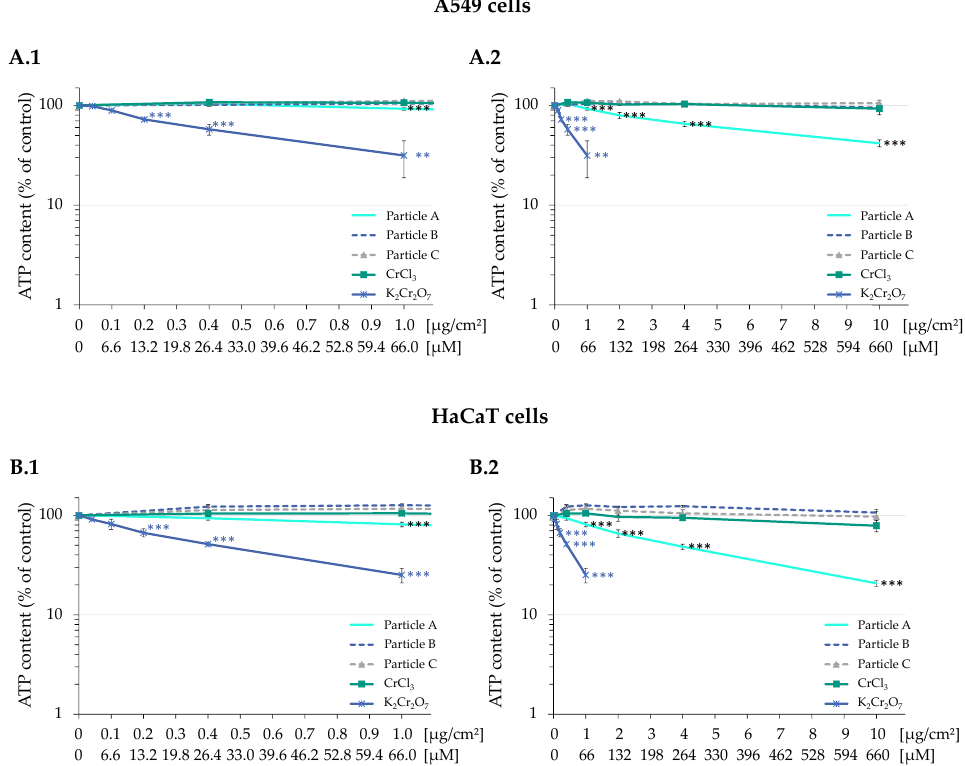
Figure 2. ATP content of A549 ( A ) and HaCaT ( B ) cells after 24 h treatment with Cr(III) oxide particles Cr 2 O 3 , CrCl 3 , or K 2 Cr 2 O 7 . Treatments below 66 µM (corresponding to 1 µg/cm 2 chromium) are shown in ( A.1 ) and ( B.1 ). Treatments covering the entire dose range investigated are depicted in ( A.2 ) and ( B.2 ). Mean values ± standard deviations derived from three independent experiments are shown. Statistics were performed using ANOVA followed by Dunnett ’ s T post hoc test: ** p ≤ 0.01, *** p ≤ 0.001.